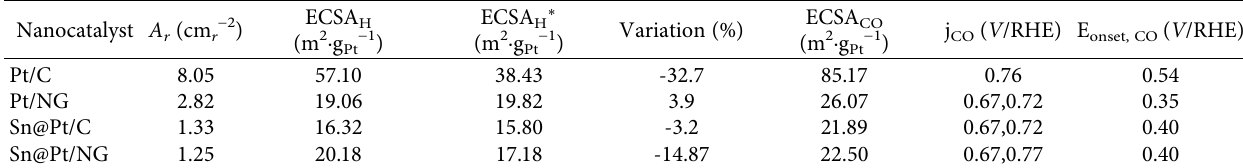
Figure 4: CVs of the nanocatalysts before and after ADT. (a) Pt/C, (b) Pt/NG, (c) Sn@Pt/C, (d) Sn@Pt/NG. Electrolyte: 0.5M · H saturated with N 2 . Scan rate: 20 mV · s − 1 . Table 3: Electrochemical parameters of the nanocatalysts from CV and CO-stripping